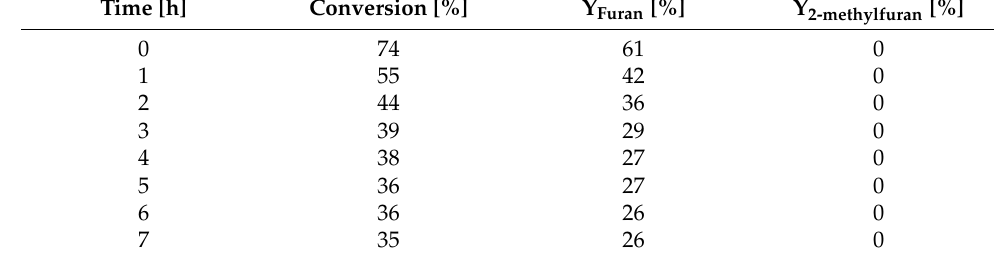
Figure A4. An optical evidence for the coking of the investigated samples during catalytic experiments. Table A1. Stability test for the H-Z catalyst at 350 °C.